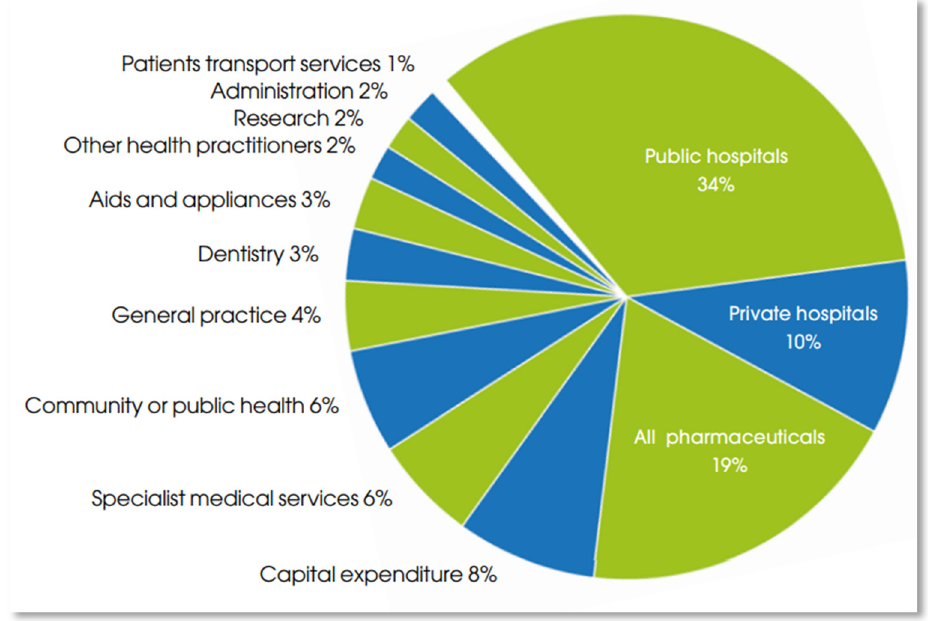
Figure 2. The proportion of CO2e emissions from the various categories of the Australian healthcare sector, 2014-15. (Malik, Lenzen, McAlister, McGain. Lancet Planetary Health 2018; 2:27–35).